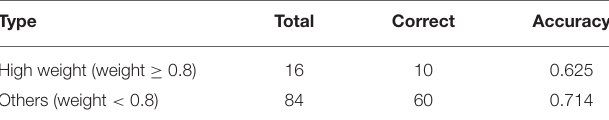
TABLE 8 | The result of the evaluation of interpretability. Type Total Correct